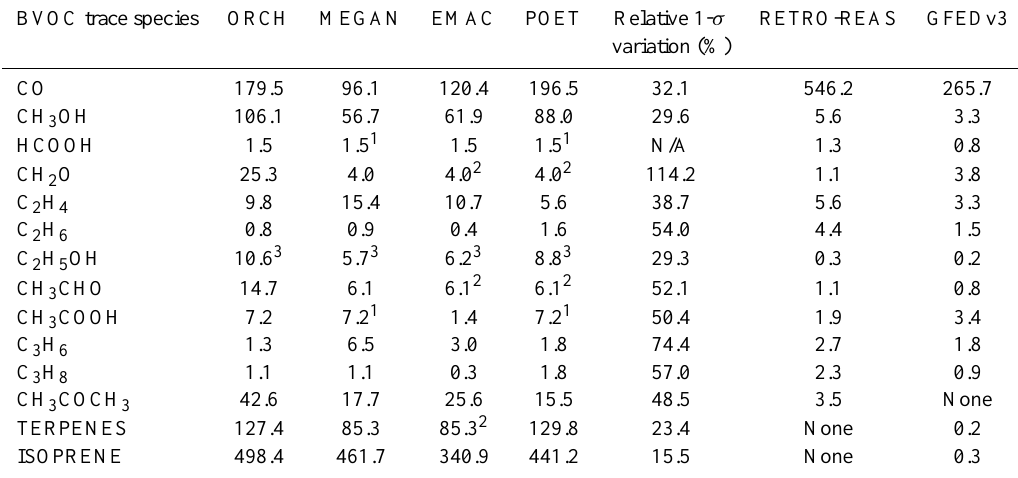
Table 2. Emission totals for BVOC fluxes for the various model simulations. All emission fluxes are given as TgCyr − 1 except for CO, which is given as TgCOyr − 1 , along with the relative variability with respect to the ensemble mean emissions. The corresponding anthropogenic and biomass burning emissions fluxes are also given. Other details: 1 Taken from Lathiere et al. (2006), 2 taken from Lamarque et al. (2010), 3 Estimated as 10% of CH 3 OH